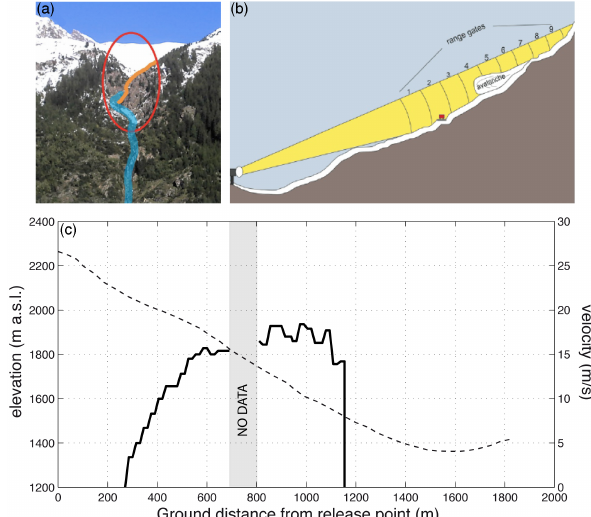
Figure 2. View of the Grosstal avalanche path (blue line) from the monitoring radar (a) . The red circle denotes the sector of the avalanche path monitored by the radar, while the orange line iden- tifies a ridge that prevents monitoring of the path between 700 and 800m ground distance from release point. The radar is able to detect the moving front of the avalanche in several range gates (b) within a ground distance from the release point spanning from ∼ 250 to 1150m from the release point (red are in a ). (c) Velocity profile of the 23 December 2012 event as measured by the radar. The avalanche path profile is represented by the black dashed